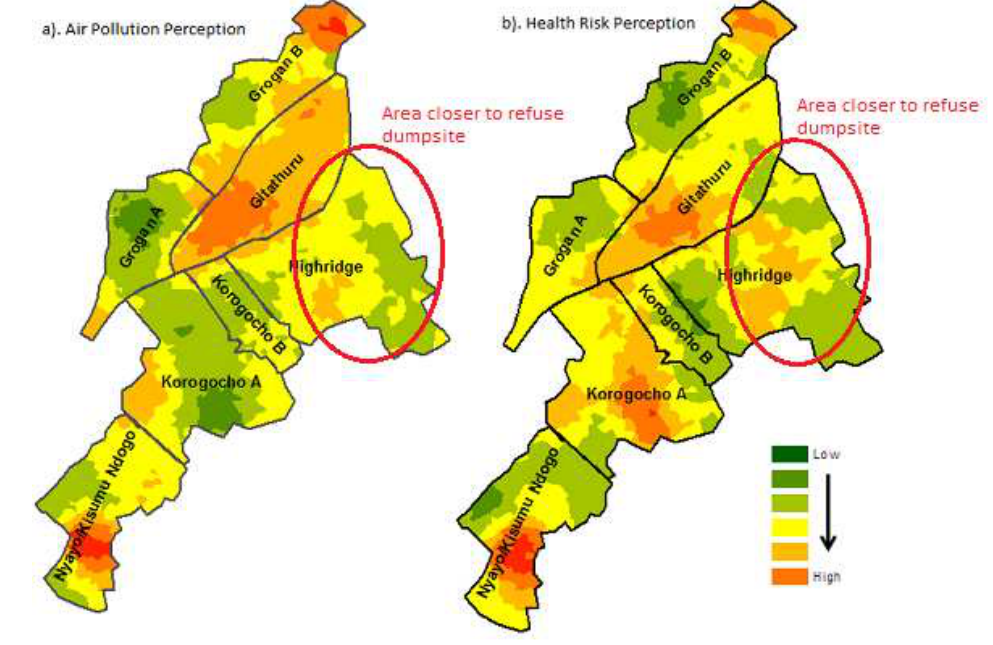
Figure 2. Perceptions on the level of air pollution and related health risks across villages in Korogocho.